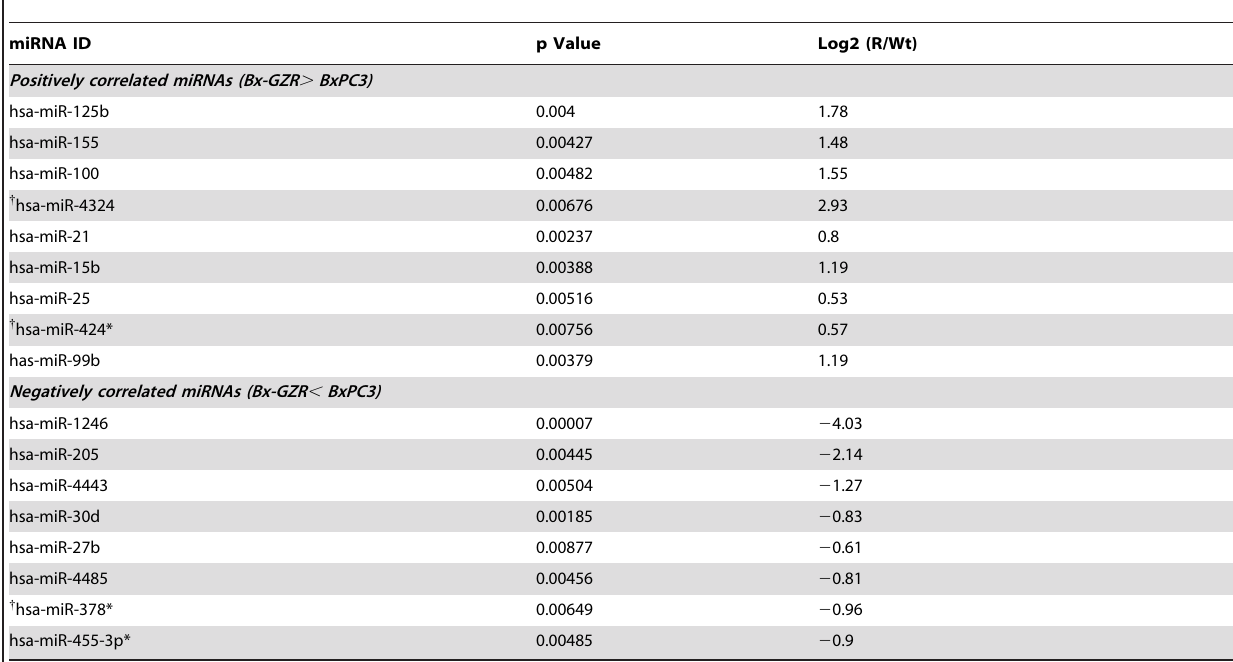
Table 1. The list of miRNAs that are highly significant in terms of expression in the gemcitabine resistant BxPC3-GZR cells compared to control BxPC3